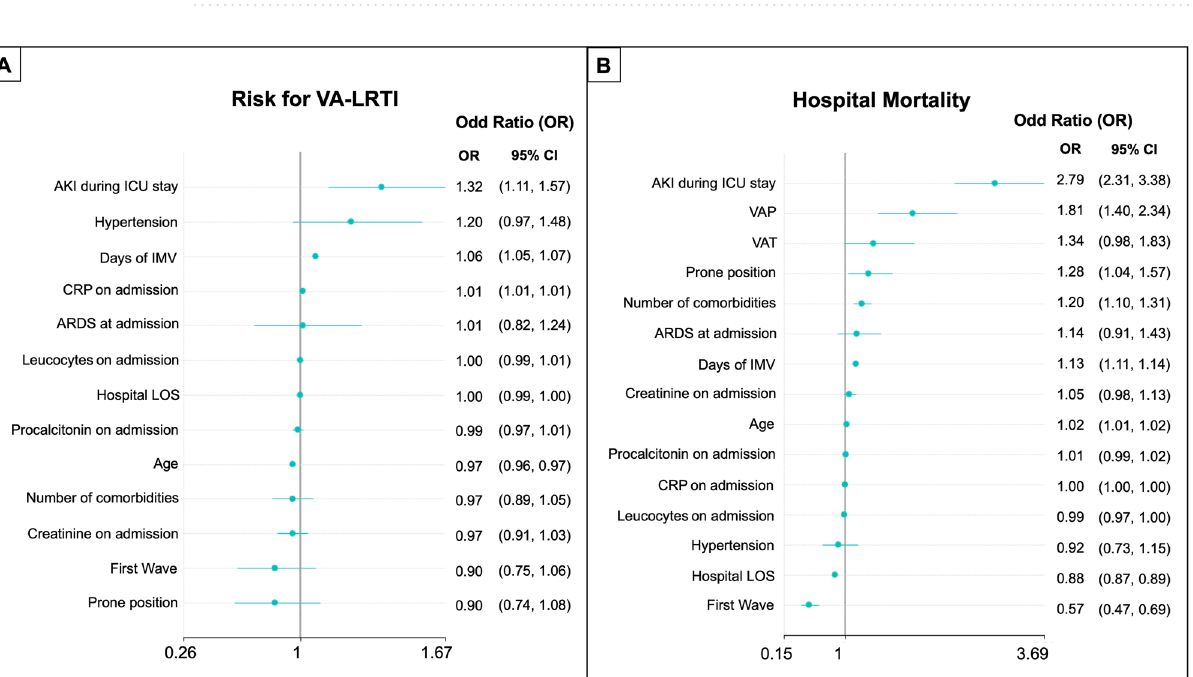
Figure 3. An automatized model to determine the impact of ventilator-associated lower respiratory tract infection on hospital mortality. ( A ) Presents variables more strongly associated with hospital mortality according to the Gini importance. ( B ) Represents the contribution of the variables to the output; the red values indicate a high-value contribution of the variable, and the blue values are a low-value contribution. The positive values in the plot indicate a high probability of hospital mortality, and negative values indicate a low likelihood of hospital mortality. ( C ) Presents each cross-validation trial’s receiver operative curve (ROC) for the subset of the selected variables. The blue curve represents the average of the ROC curves of each test, and the average area under de ROC is also presented. The most significant variables associated with hospital mortality according to their Gini importance and contribution to the output were Hospital-LOS, higher days under IMV, old age, higher creatinine levels on admission, and lower PaO2/FiO2 on ICU admission. Also, the development of AKI during ICU stays and VA-LRTI were risk factors associated with hospital mortality.